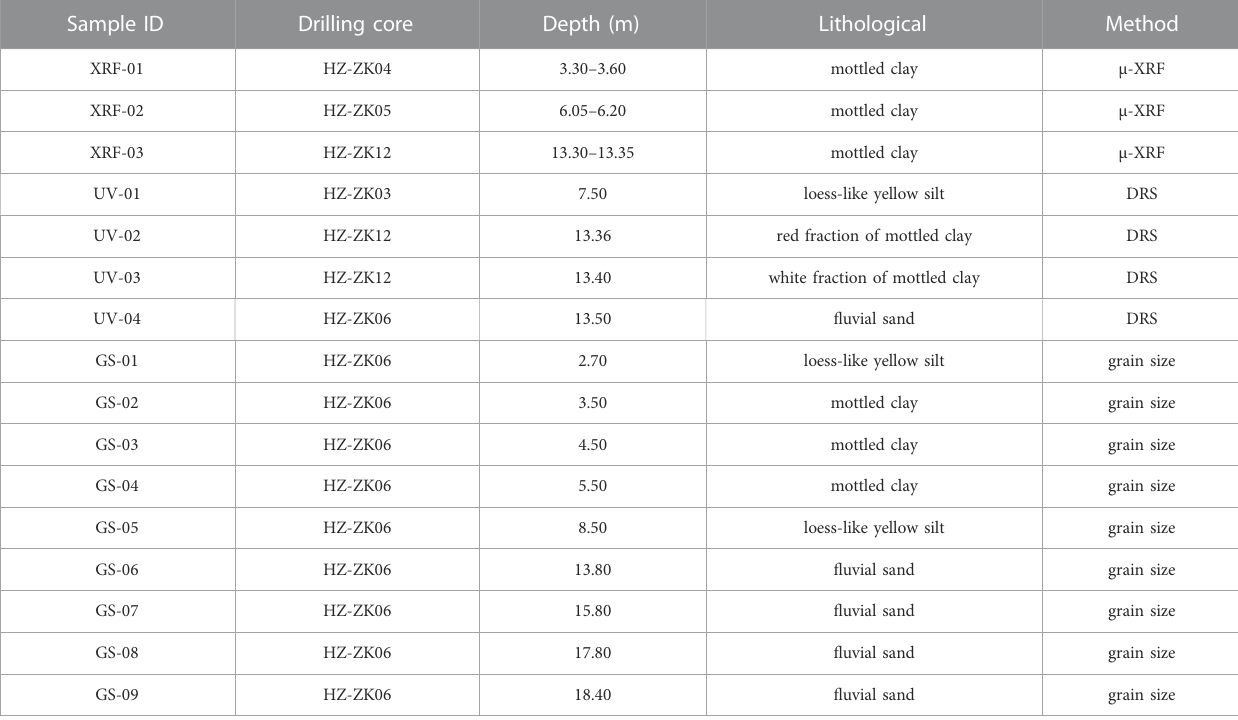
TABLE 3 Sampling information and analysis